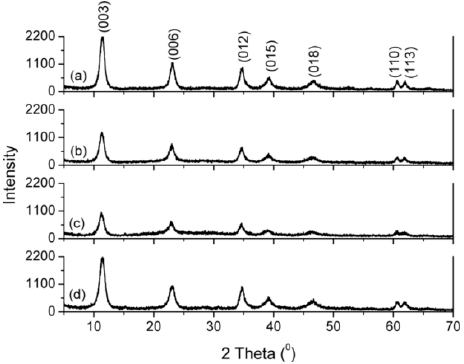
Figure 1. XRD (X-Ray diffraction) patterns of the synthesized layered double hydroxides Figure 1. XRD (X ‐ Ray diffraction) patterns of the synthesized layered double hydroxides (LDHs). ( a ) S–